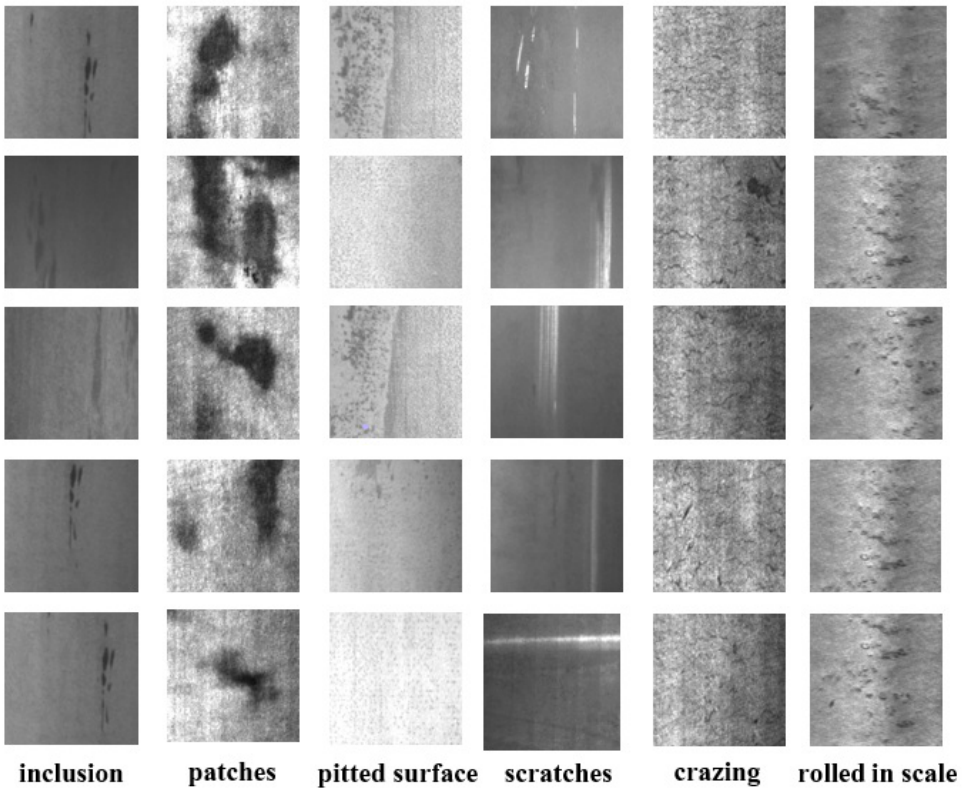
Figure 3. Typical surface defect samples in the NEU-DET